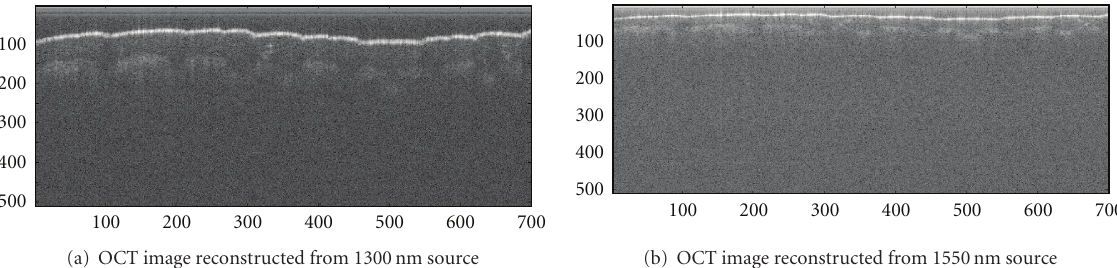
Figure 4: OCT images of a finger. (a) Reconstructed by 1300 nm swept source; (b) reconstructed by 1550 nm swept source.